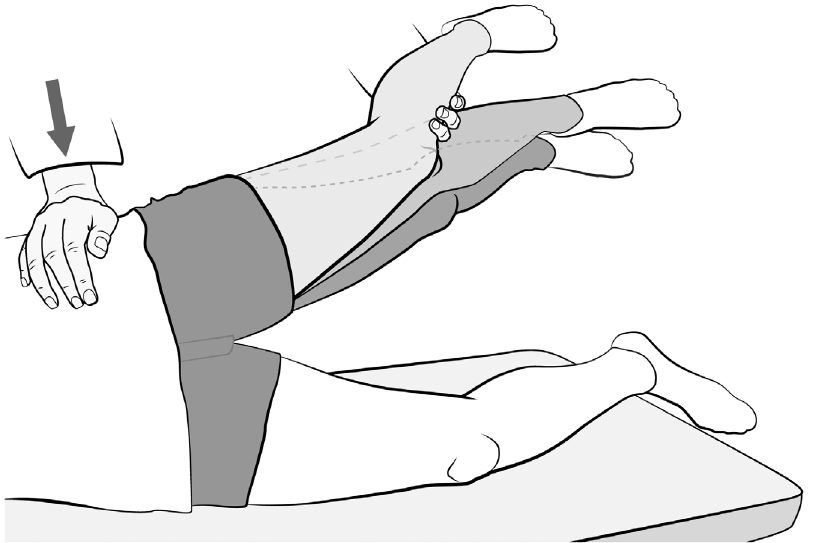
Figure 2. The Hip Lag Sign. Shown is the Hip Lag Sign as it is defined in this work: To test for the Hip Lag Sign, the patient has to lie in a lateral, neutral position with the affected leg being on top. The examiner then positions one arm under this leg to have good hold and control over the relaxed extremity, whereas the other hand stabilizes the pelvis. The next step is to passively extend to 10 u in the hip, abduct and rotate internally as far as possible, while the knee remains in a flexed position of 45 u . After the patient is asked to hold the leg actively in this position, the examiner releases the leg. The Hip Lag Sign is considered positive, if the patient is not able to keep the leg in the aforementioned abducted, internally rotated position and the foot drops more than 10 cm.